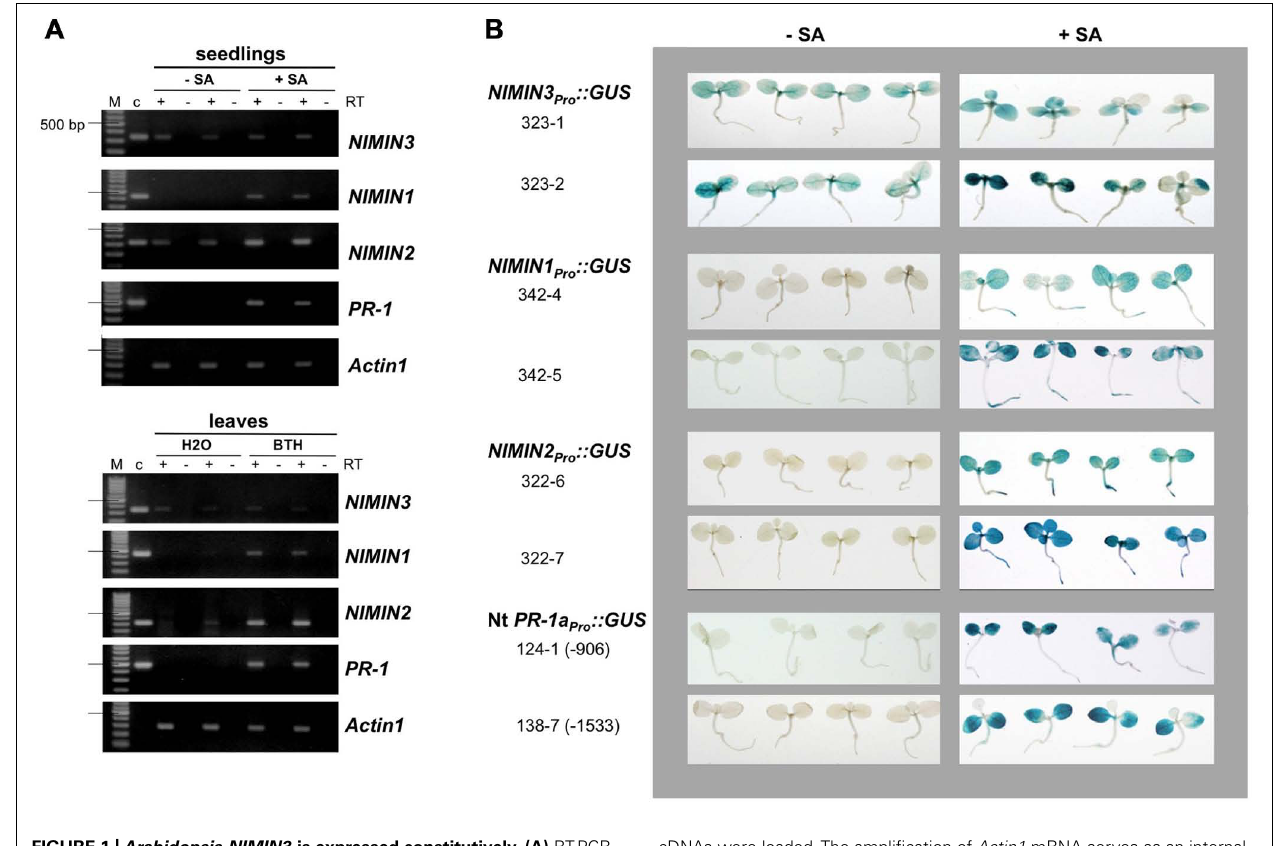
FIGURE 1 | Arabidopsis NIMIN3 is expressed constitutively. (A) RT-PCR analyses of NIMIN3 expression in Arabidopsis whole seedlings and leaf tissue. Expression of NIMIN3 is compared to expression of NIMIN1 , NIMIN2 , and PR-1 . RNA samples were isolated from 2-week-old whole seedlings grown either on MS medium or MS medium with addition of 0.3 mM SA and from leaves of 4-week-old plants 24 h after spraying with water or a suspension of Bion ® containing 0.34 mM BTH. RT-PCR analyses were performed on DNase I-treated total RNA preparations in presence or absence of reverse transcriptase (RT) with primer combinations listed in Table 1 . In lanes c, PCR products from 1 ng of plasmid DNAs carrying the respective